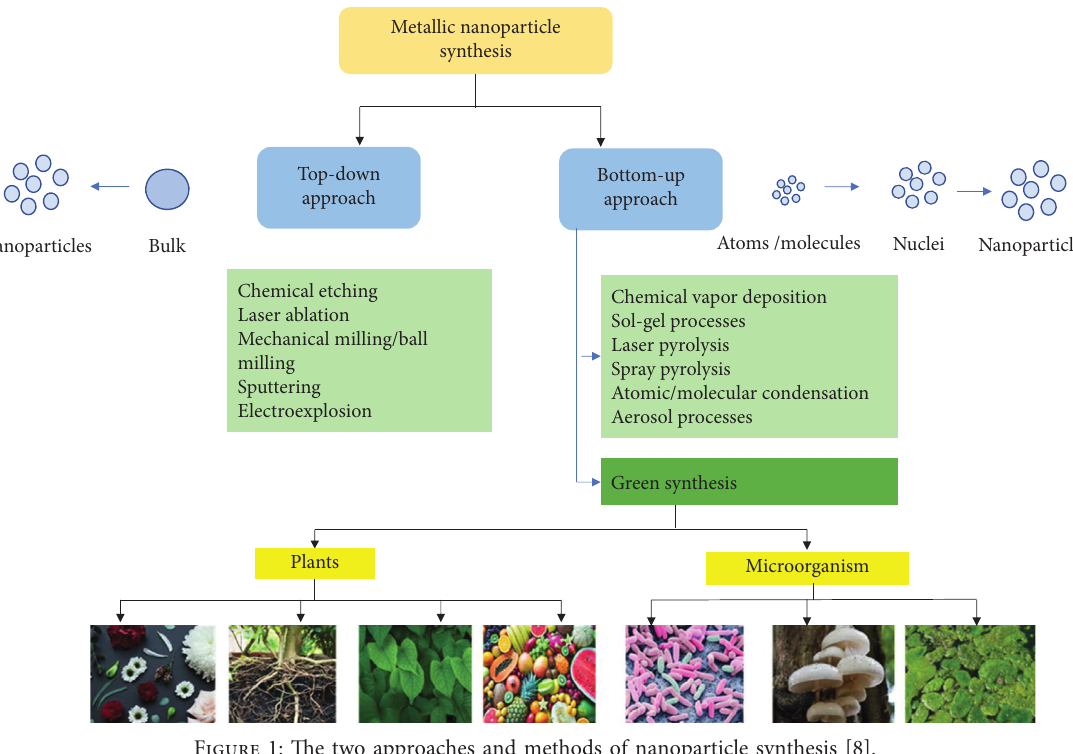
Figure 1: The two approaches and methods of nanoparticle synthesis [8].